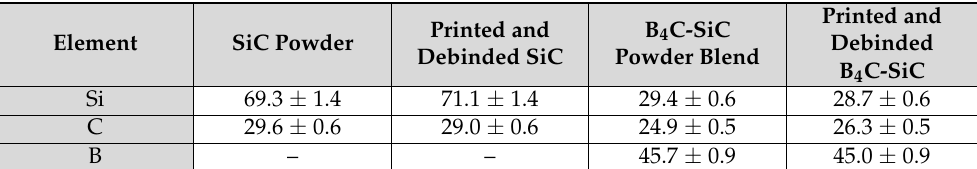
Table 1. Chemical analysis of samples showing the wt.% of elements of powder before printing and after printing and debinding.